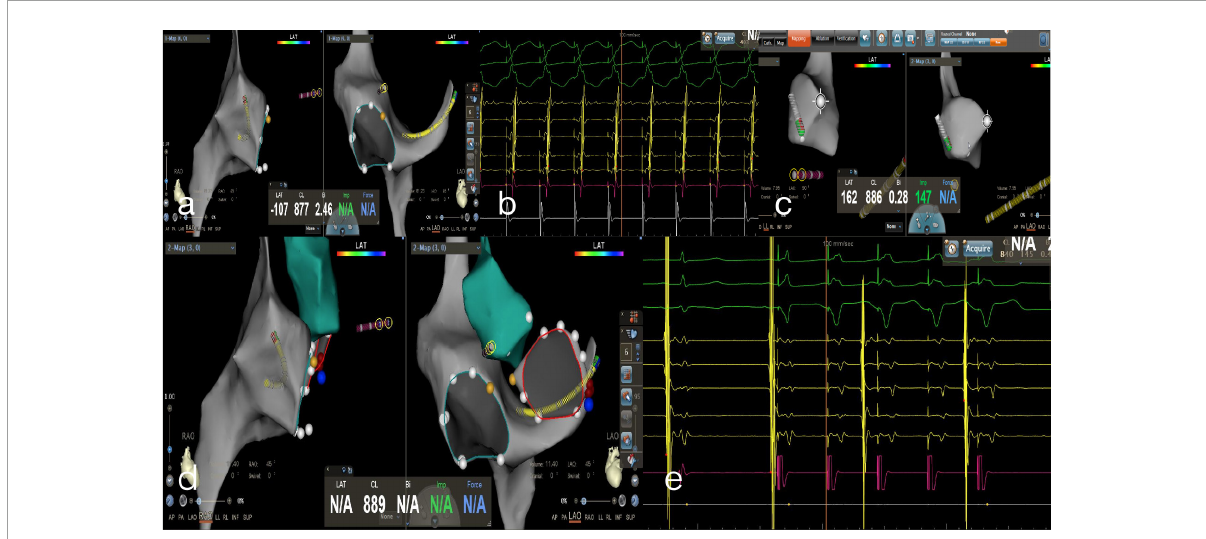
FIGURE4 Zero-fluoroscopy radiofrequency ablation for AVRT. (a) Modeling of the right atrium was performed with a Decanav catheter using the CARTO 3 System. The Decanav catheter was placed in the coronary sinus and a quadripolar catheter was placed in the apex of the right ventricle. (b) During the onset of SVT stimulated by S1S1, the retrograde A wave showed eccentric conduction and was diagnosed as a left concealed accessory pathway. (c) The retrograde aortic method was used to deliver the ablation catheter to the aortic root and establish a model of the aorta. (d) The ablation catheter electrode crosses the aortic valve to model the mitral annulus, and the ablation target is located at three o’clock. (e) An electrophysiology study showed ventricular pacing with ventricular-atrial separation and retrograde transmission through atrioventricular node. The retrograde A wave was